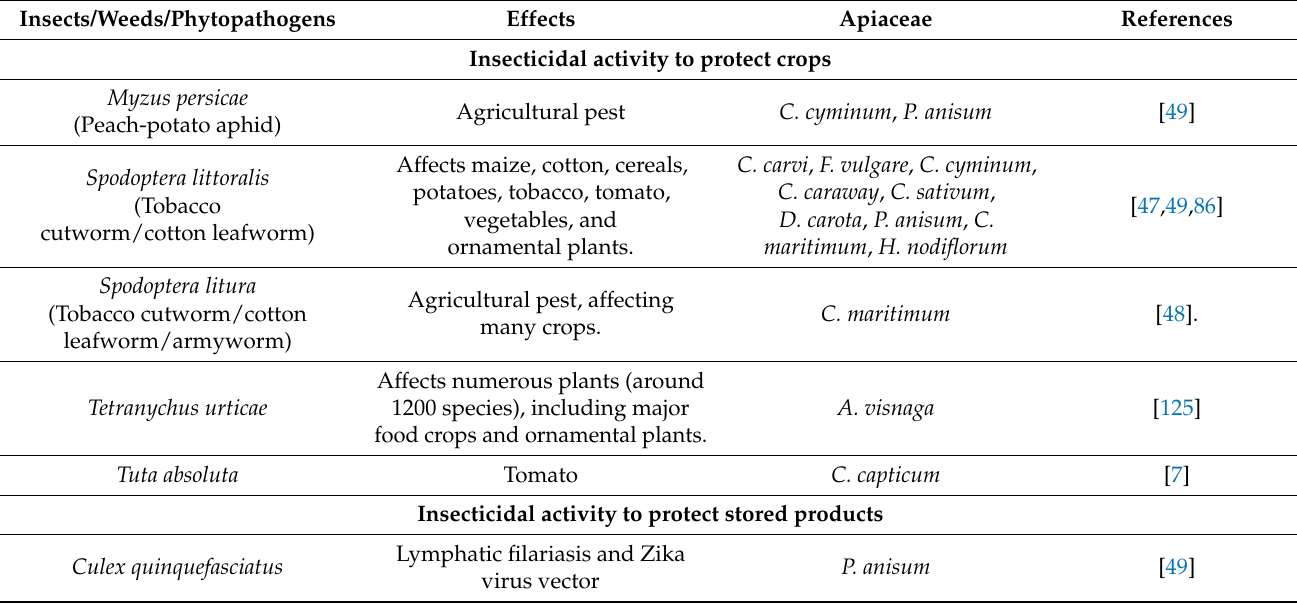
Table 3. Potential use of Apiaceae extracts as